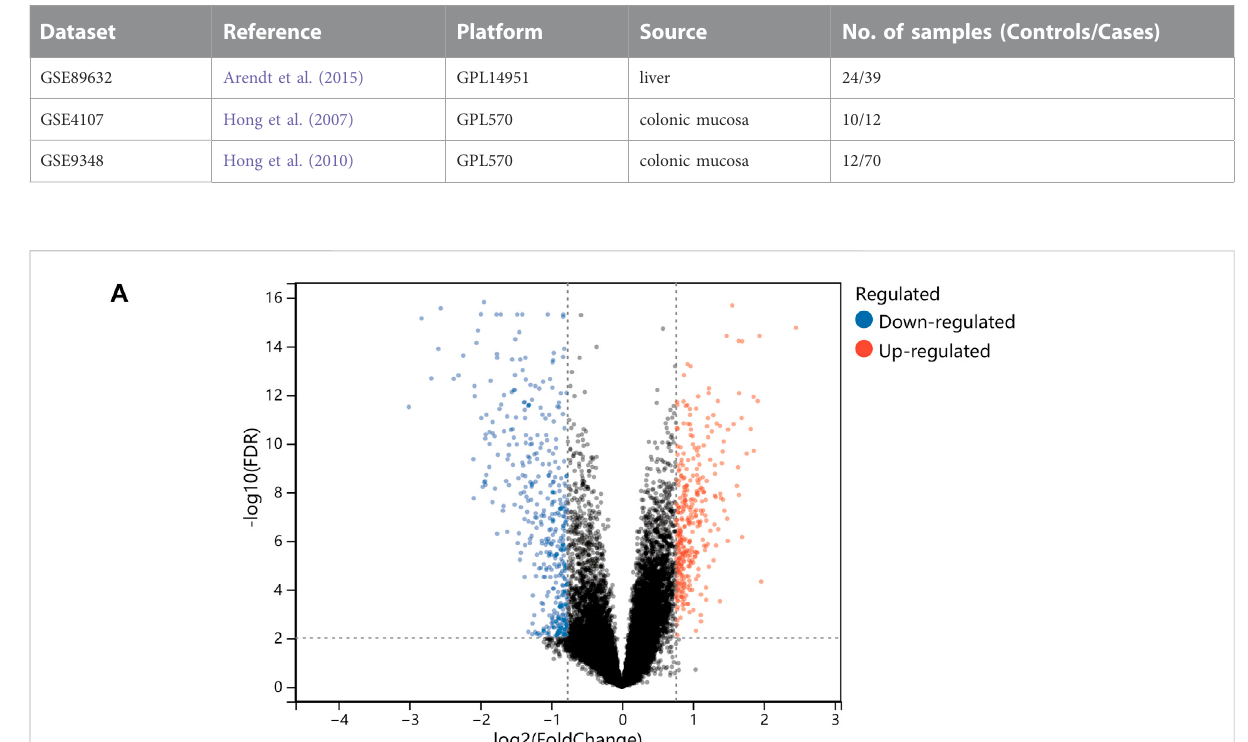
TABLE 1 Information on the datasets included in the current study.